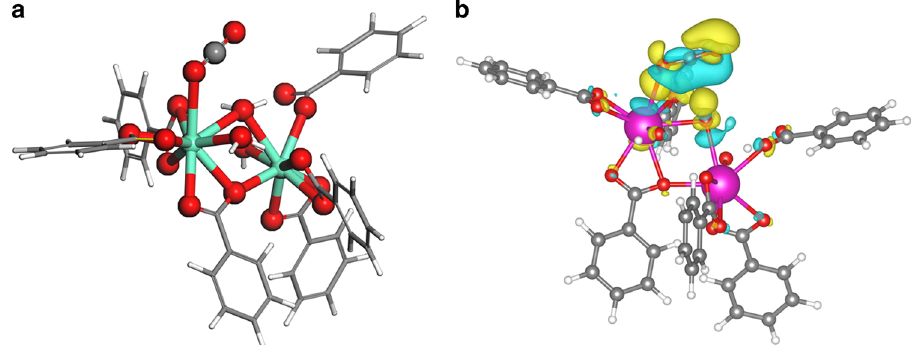
Fig. 6 Density functional theory calculation. a The calculated CO 2 adsorption structure. b Charge difference density of CO 2 adsorption structure of Eu(II) 2